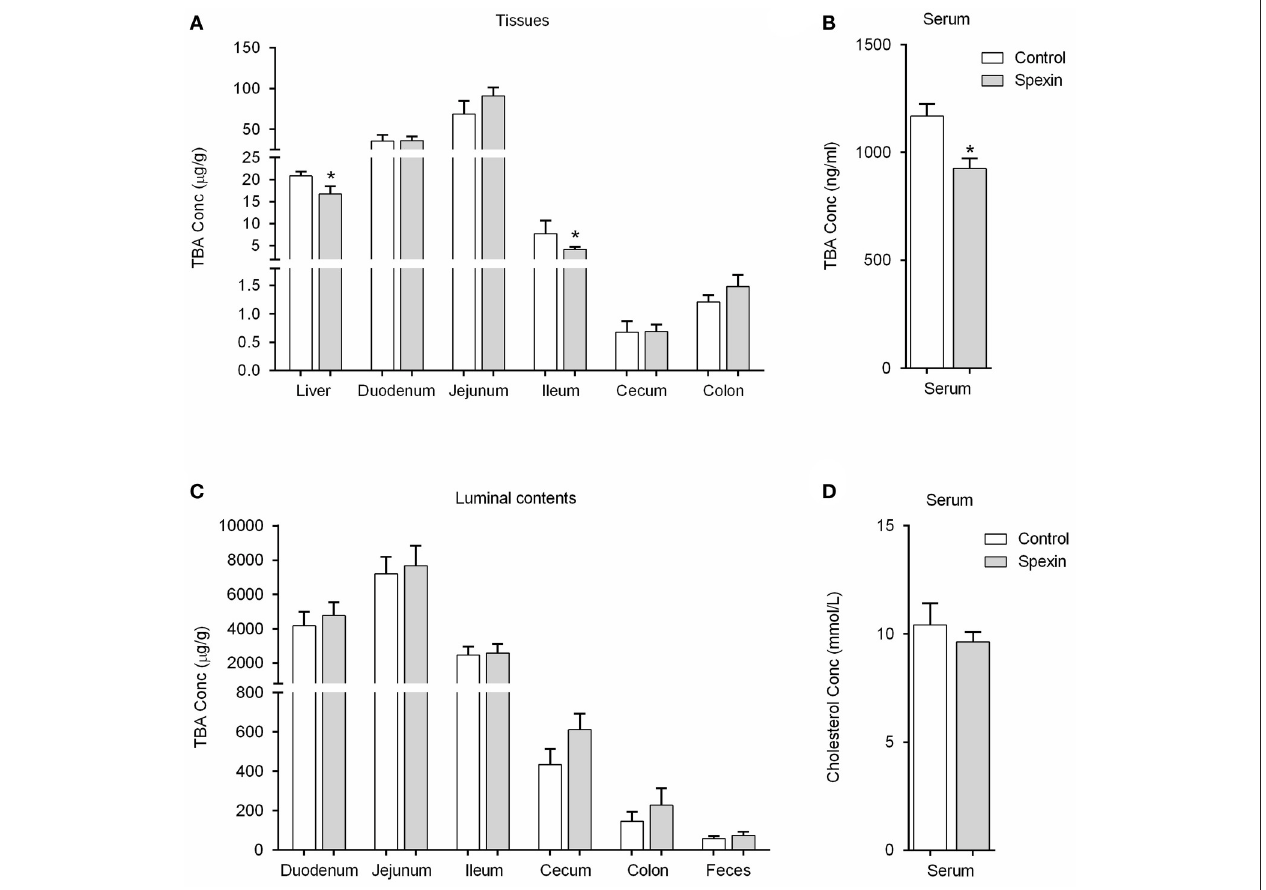
FIGURE 2 | Spexin-induced alteration of bile acid pool in the enterohepatic circulation system. Rats were injected i.p. with spexin (300 µ g/kg) prepared in saline. One hour later, the rats were sacrificed for tissue sample collection. The rats injected i.p. with saline were served as control group. The samples of serum, tissues, luminal contents, and feces were subjected to further bile acid quantification. (A) Spexin-induced alteration of the TBA in individual tissues in rat. (B) Spexin-induced alteration of the TBA in rat serum. (C) Spexin did not alter TBA levels in rat luminal contents and feces. (D) Single injection of spexin cannot affect the TC concentration in rat serum. Results are shown as Mean ± SEM ( n = 8/group). * p < 0.05 vs. control resulting from Student’s t -test. Effect of spexin on individual bile acids throughout the enterohepatic circulation was also evaluated, see in Figures S1,